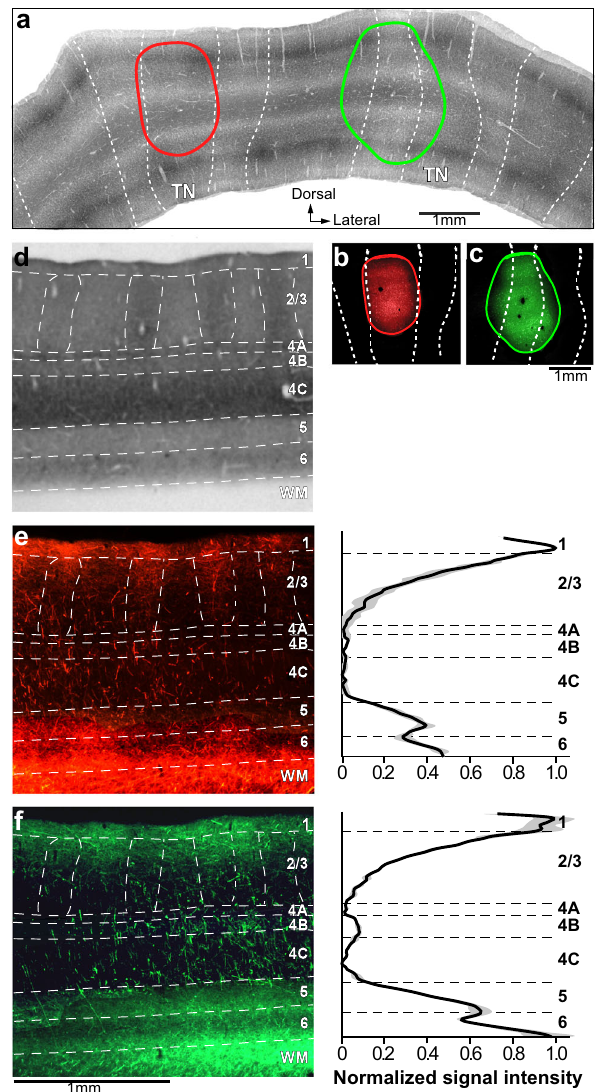
Fig. 1 Laminar distribution of V2 feedback projections to V1. Case MK359LH. a Micrograph of a merged stack of V2 sections stained for CO, to reveal the stripes (delineated by dashed white contours). Red and green ovals are the composite outlines of an AAV9-tdT and AAV9-GFP injection site, respectively, taken from ( b , c ) and overlaid onto the V2 CO stack. TN: thin stripes. b , c Micrographs of representative AAV9-tdT and AAV9-GFP injection sites taken under fl uorescent illumination. While the images are from a single tissue section, the red and green outlines mark the full extent of the injection sites through the layers, and were generated by aligning images of injection sites through the depth of the cortex. d Image of CO-stained section through the layers of V1 (indicated on the right side). White dashed contours delineate layer boundaries, and the CO blobs in L2/3. The same tissue section, but imaged for fl uorescent label, is illustrated in ( e ) and ( f ). e Left: Image of tdT- labeled FB axons through V1 layers resulted from the thin stripe injection shown in panels ( a , b ). Right: Population mean (solid line)±s.e.m. (gray shading) of normalized fl uorescent signal intensity across V1 layers following thin stripe injections ( n = 2). f Same as ( e ) but for FB label resulted from injections ( n = 2) that were centered on a pale-lateral stripe, but spilled into adjacent thick and thin stripes. Statistical analysis of differences between stripe types is reported in the “ Results ” . Scale bar under left panel in ( f ) is valid for ( d ) and left panels in ( e , f ). Results in ( a – d ), and left panels in ( e , f ) are representative of four independent injections centered in thin ( n = 2) or pale ( n = 2) V2 stripes. Source data for right panels in ( e , f ) are provided as a Source data fi